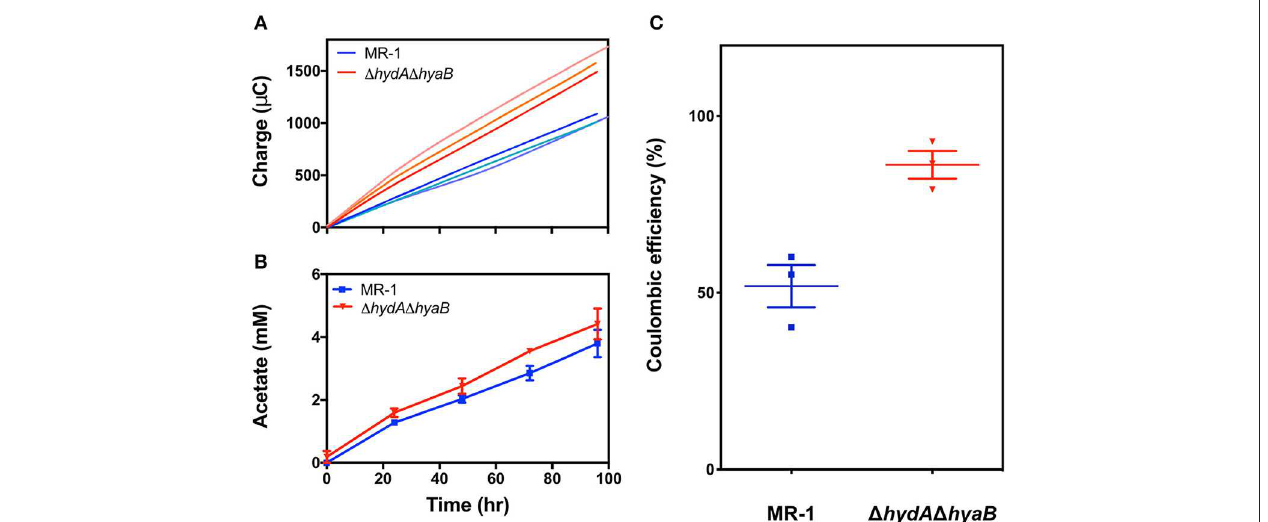
FIGURE 3 | Deletion of hydrogenases diverts electron flux toward the anode, increasing efficiency of electron recovery. (A) Recovered charge measured for reactors containing MR-1 (blue) as compared to 1 hydA 1 hyaB (red), reflecting the faster rate of current production by hydrogenase mutants. Each line represents one of three replicate reactors. (B) Acetate production rates for MR-1 (blue) and 1 hydA 1 hyaB (red), revealing similar rates of electron donor consumption, measured by HPLC in triplicate reactors. Error is represented as SEM. Time on the x-axis reflects time since replacing the medium in reactors containing mature biofilms with fresh 30mM lactate and 1 µ M riboflavin. (C) Coulombic efficiency measured as mole equivalents of electrons transferred to the anode vs. mole equivalents of electrons produced by lactate oxidized to acetate in MR-1 (blue) and 1 hydA 1 hyaB (red) in reactors with vented cathodes. Three independent experiments are shown for each strain with error representing SEM.